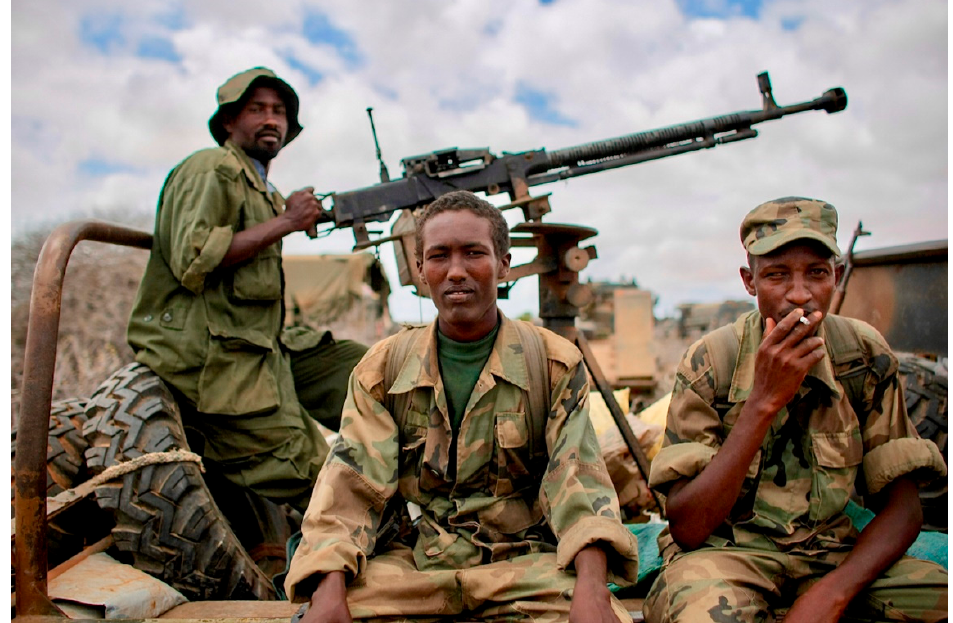
Figure 13. African Union Mission in Somalia (AMISOM) soldiers in Jubaland, Somalia, to combat insurgent militias; photo credit Stuart Price.